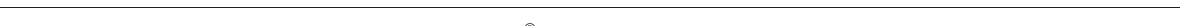
FIGURE 1 | fluorescent tdTomato signals and weakly accumulate Qtracker ® over time (here 1.5h post-injection is shown). After fluorescence overlay, neutrophils are displayed in magenta. This enables additional differentiation from autofluorescence by mixed color. Only residual Qtracker ® (blue) from leakage or clotting and no blood staining is visible since i.v. injection occurred 1.5h prior to image acquisition in this case. MOPC EGFP tumor cells are in green. Collagen fibers of the basal membrane and dermal matrix are visualized through SHG signal (white). Image 1 represents the epidermal-basal membrane border. (C) Means ( + /– SEM) of tumor lesion volumes at different time points after tumor cell injection. Day 0 = 120–180min after tumor cell injection. N = 6 animals. (D) Definition of tumoral compartments. Tumor volume was assessed by semi-automated surface generation of tumor cells (solid green). TAN inside tumor surface area were termed “intratumoral,” cells outside were designated as “peritumoral.” Cross-section through tumor volume reveals intra- vs. peritumoral TAN. (E) Intravital multidimensional 2-Photon images of representative tumor cell lesions in MIP from days 0 (120min after tumor cell injection), 3, and 6 are depicted. 3D reconstruction was performed with Imaris ®